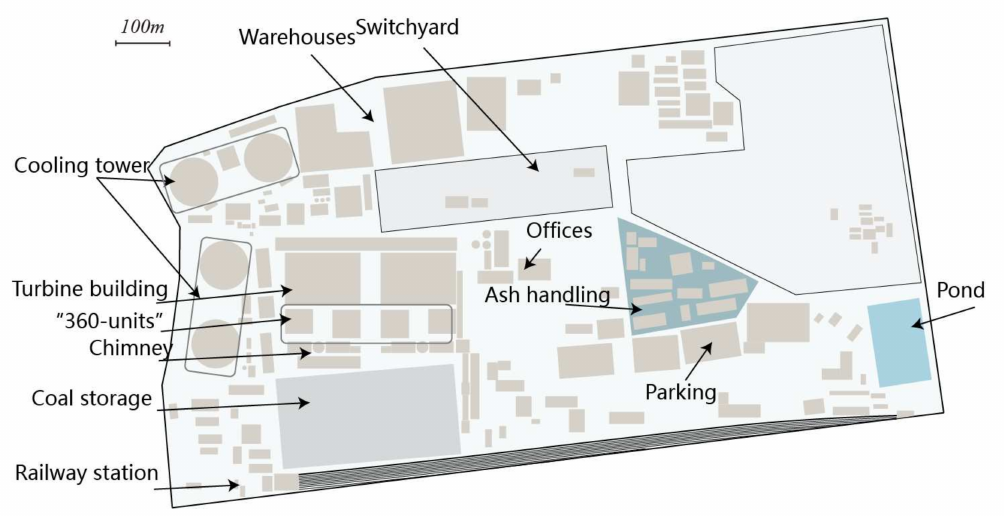
Figure 10. Huaneng Yangliuqing power station Power Plant Site